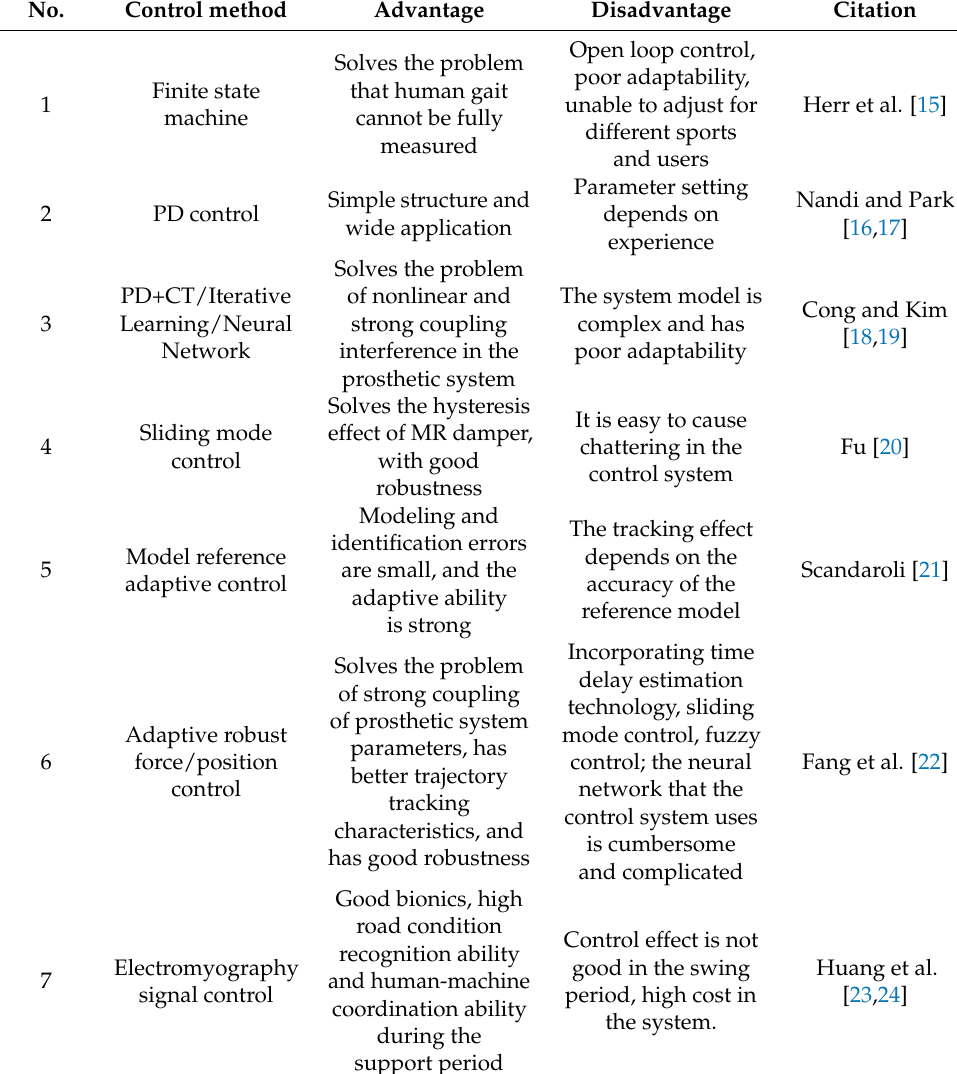
Table 1. A summary of related research work in the